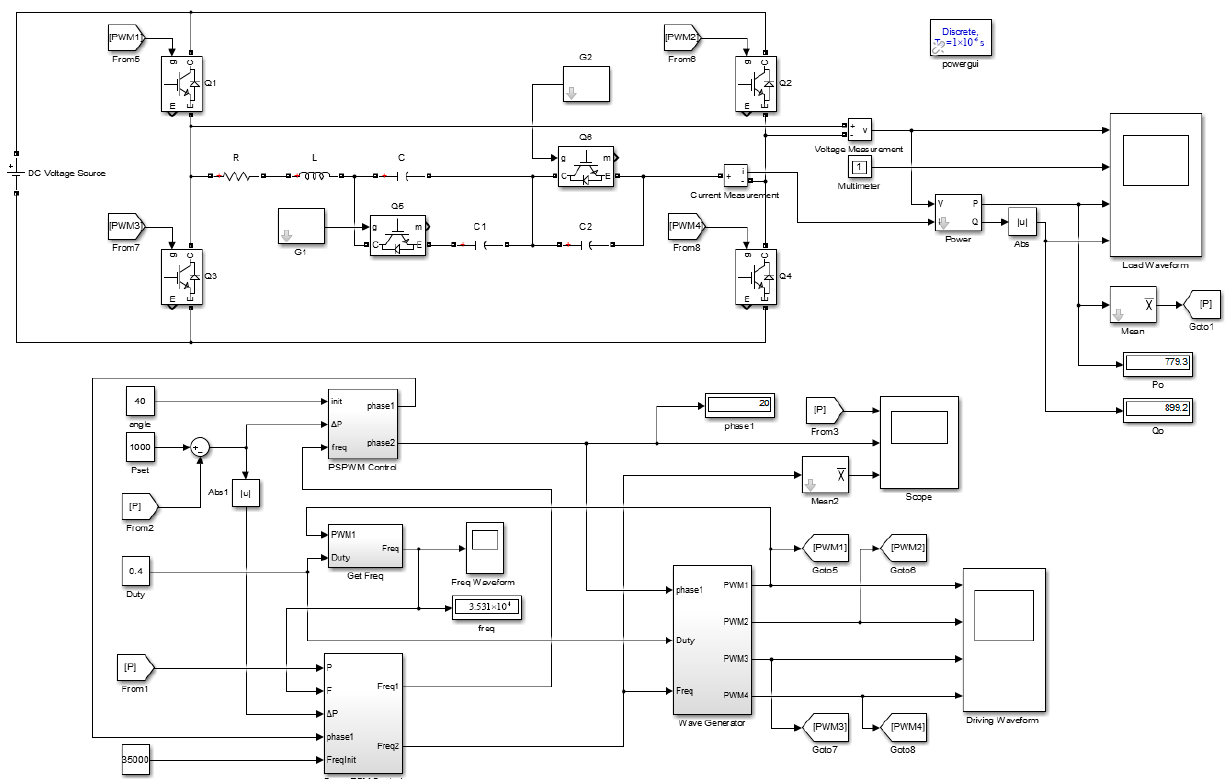
Figure 10. Simulation model of hybrid modulation algorithm.